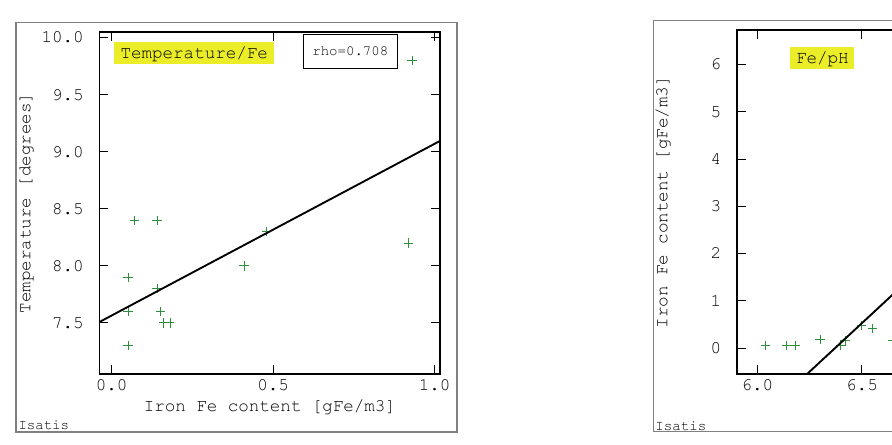
Fig. 16. Diagram correlation of iron Fe ++ content [gFe ++ /m 3 ] and potential pH in underground water, with the marked regression line Y / X in the area of water intake in the region of Kłodzko (14